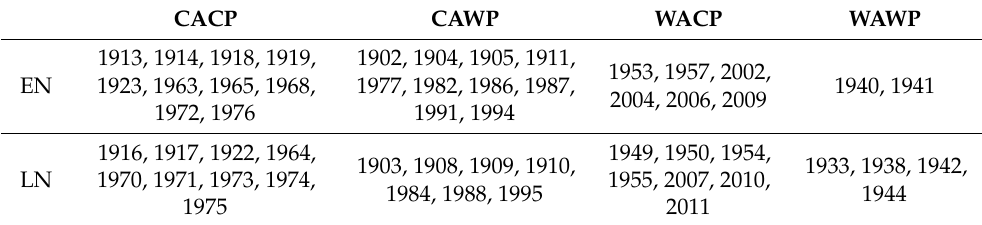
Table 2. EN and LN onset years during the 1901–2014 period stratified by the mean states. CACP CAWP WACP WAWP